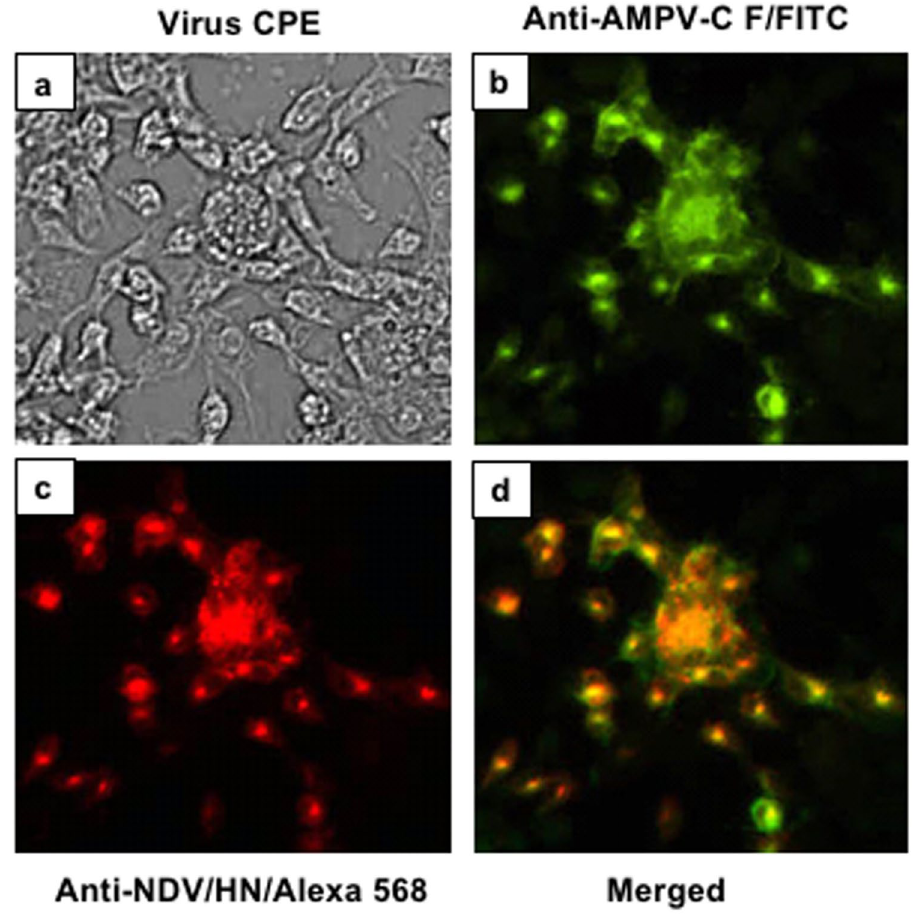
Figure 3. Detection of AMPV-C F protein expression by IFA. DF-1 cells were infected with rLS/AMPV-C F&G at an MOI of 0.01. At 24 h post-infection, the infected cells were fixed and stained with a mixture of chicken anti-AMPV-C F serum and mouse anti-NDV HN Mab followed by staining with a mixture of anti- chicken FITC and anti-mouse Alexa Fluor 568 conjugated antibodies. Stained cells were examined and digitally photographed under 100 × magnification. Detection of AMPV-C ( b ) and NDV ( c ) in rLS/AMPV-C F&G- infected cells were merged ( d ). Viral induced CPE from rLS/AMPV-C F&G virus was photographed ( a ) under bright-field.